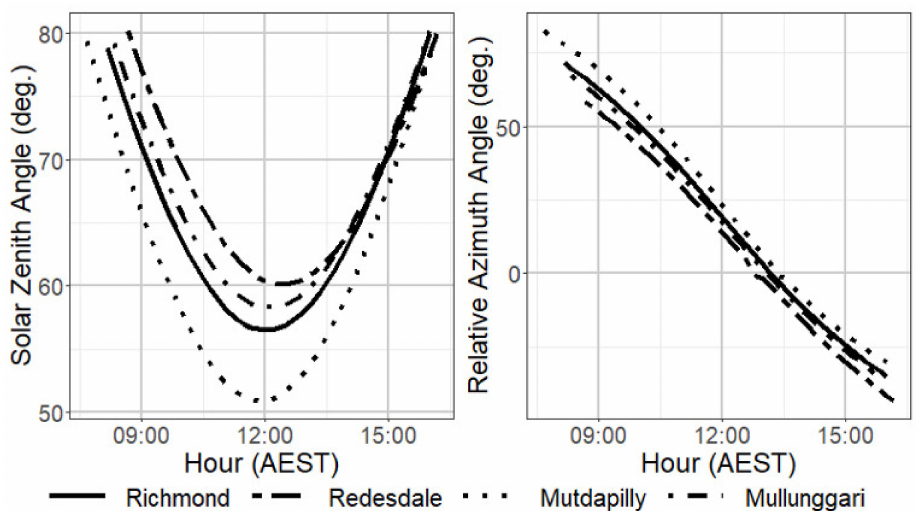
Figure 5. Diurnal variations of solar zenith angles ( left ) and relative azimuth angle ( right ) across the four grassland sites for one date (1 July